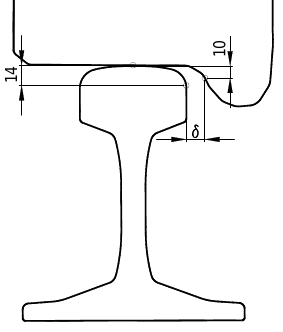
Figure 8. Wheel/rail flange clearance .